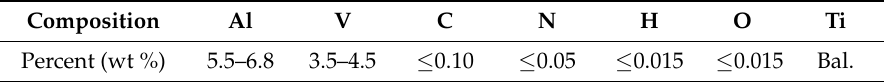
Table 1. Nominal chemical composition of the Ti-6Al-4V